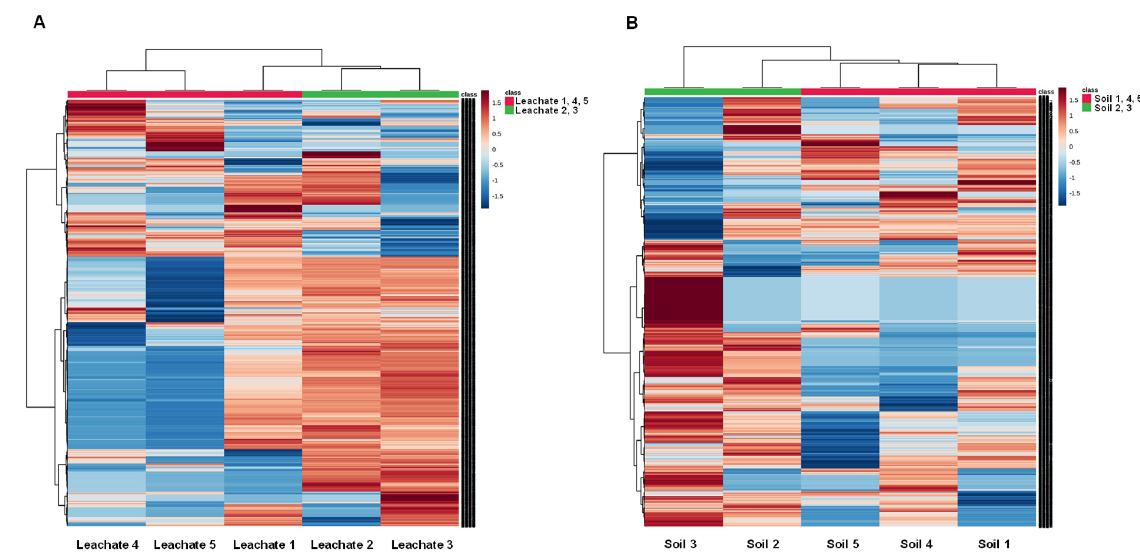
Figure 11. Hierarchical clustering heatmaps representing MS features are significantly ( p < 0.05) different between groups for ( A ) leachate and ( B ) soil samples. The analysis was performed using an Euclidean distance measure and Ward’s distance measure algorithm; The rows display m / z values, and the columns represent samples. The blue colour of the tile indicates low abundance, and red indicates high abundance.